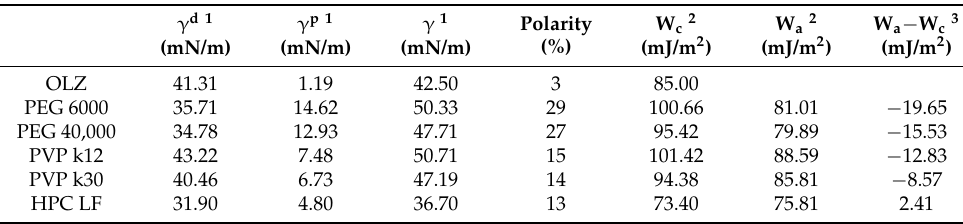
Table 1. Surface energy of olanzapine and polymers.